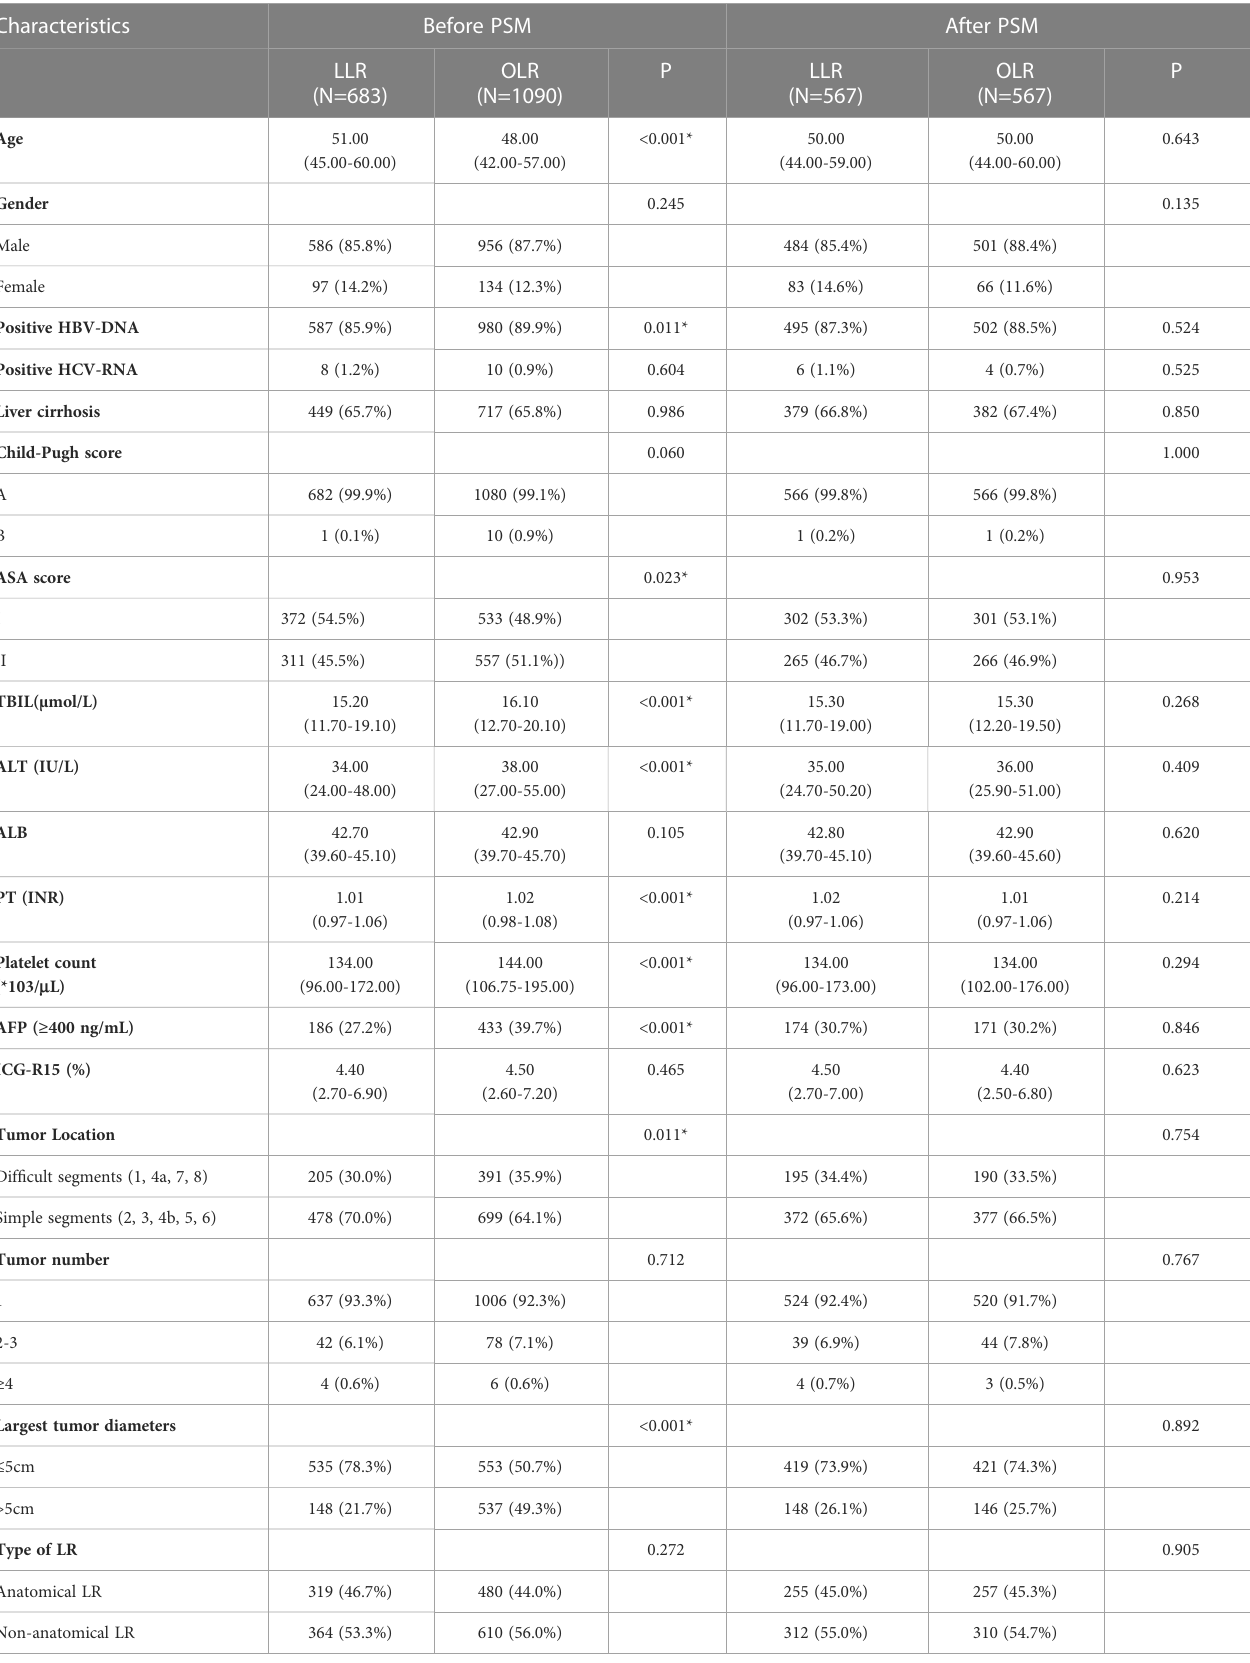
TABLE 1 Baseline patient characteristics between laparoscopic liver resection (LLR) and open liver resection (OLR) groups.